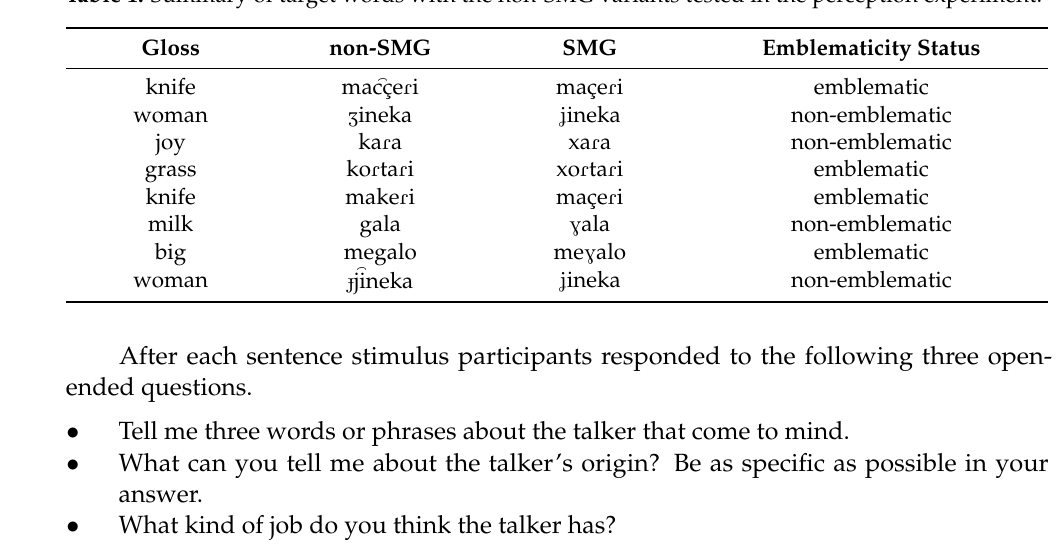
Table 1. Summary of target words with the non-SMG variants tested in the perception